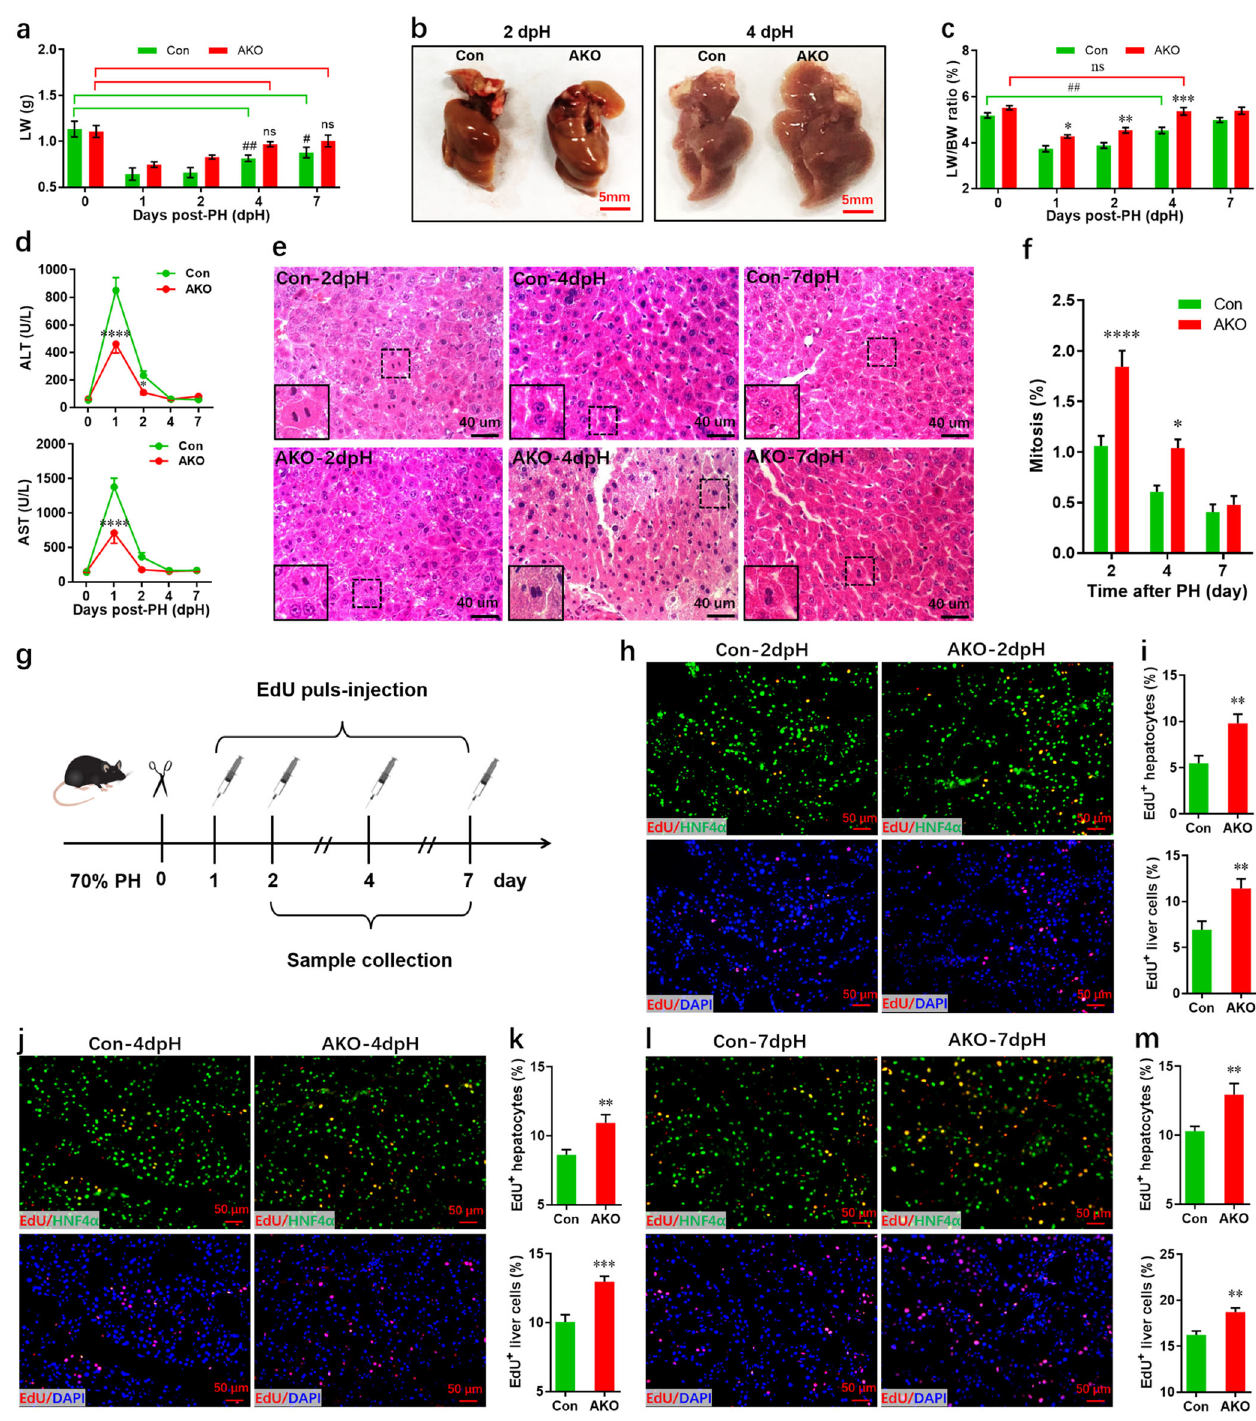
Fig. 3 Enhanced liver regeneration and hepatocyte proliferation in AKO mice after PH. a Recovery of liver weight in control and AKO mice after PH ( n = 5 ~ 8 mice per group). b Representative images of livers from control and AKO mice at 2 and 4 dpH. c The actual ratio of liver weight to body weight at the indicated time points after PH ( n = 5 ~ 8 mice per group). d Serum AST (upper) and ALT (lower) levels in control and FoxO3 -knockout mice pre- and post-PH ( n = 6 mice per group). e Representative liver sections stained with hematoxylin and eosin showing mitotic changes in hepatocytes in control and AKO mice after PH. f Quanti fi cation of mitotic hepatocytes in control and AKO mice ( n = 5 mice per group). g Schematic of an EdU pulse-chase experiment designed to label proliferating hepatocytes during liver regeneration. h , i Representative images ( h ) and quanti fi cation ( i ) of EdU + hepatocytes (upper) and liver cells (lower) in control and AKO mice at 2 dpH ( n = 8 mice per group). j , k Representative images ( j ) and quanti fi cation ( k ) of EdU + hepatocytes (upper) and liver cells (lower) in control and AKO mice at 4 dpH ( n = 8 mice per group). l , m Representative images ( l ) and quanti fi cation ( m ) of EdU + hepatocytes (upper) and liver cells (lower) in control and AKO mice at 7 dpH ( n = 8 mice per group). All data are presented as the mean ± SEM. * p < 0.05, ** p < 0.01, *** p < 0.001 versus control mice; # p < 0.05; ns, no signi fi cant difference (two-way ANOVA test for a , c , d , f , and Student ’ s t -test for i , k , and m